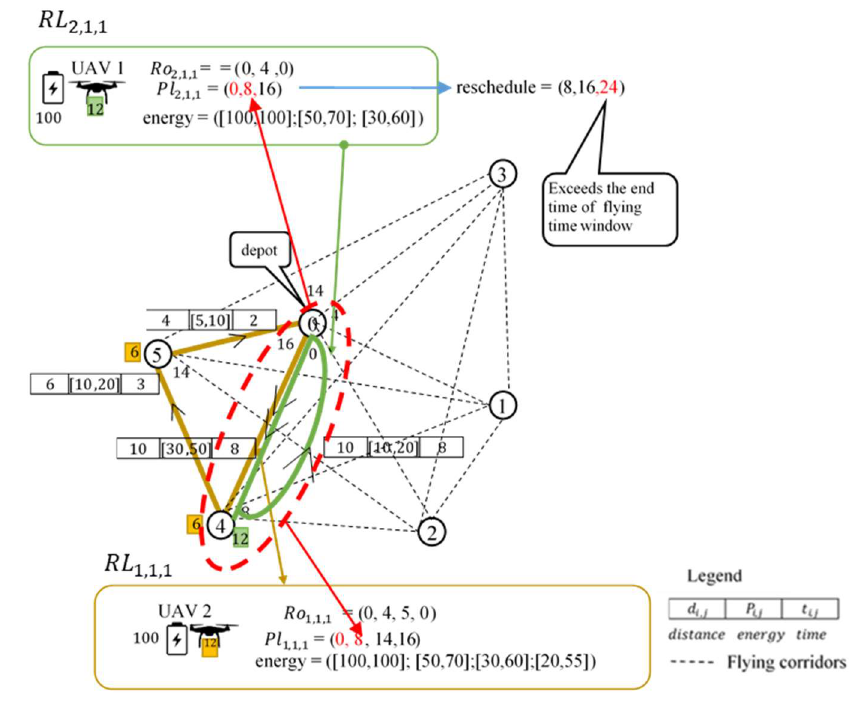
Figure 10. Scenarios assigned to UAVs with collisions, which are not possible to reschedule.